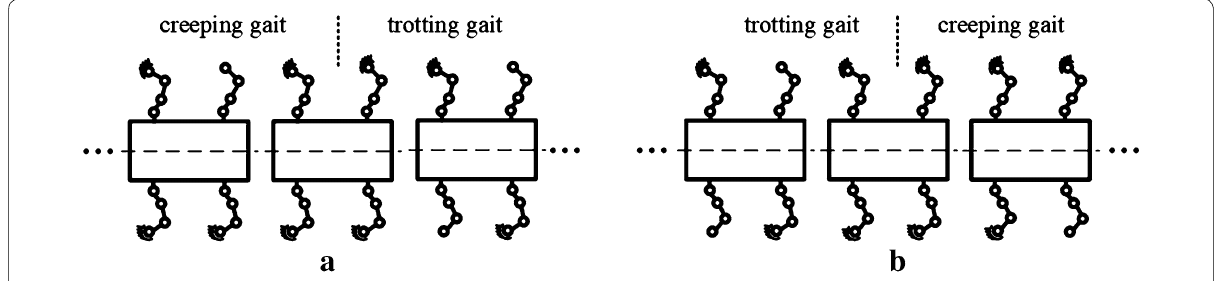
Figure 7 Transformation processes between creeping gait and trotting